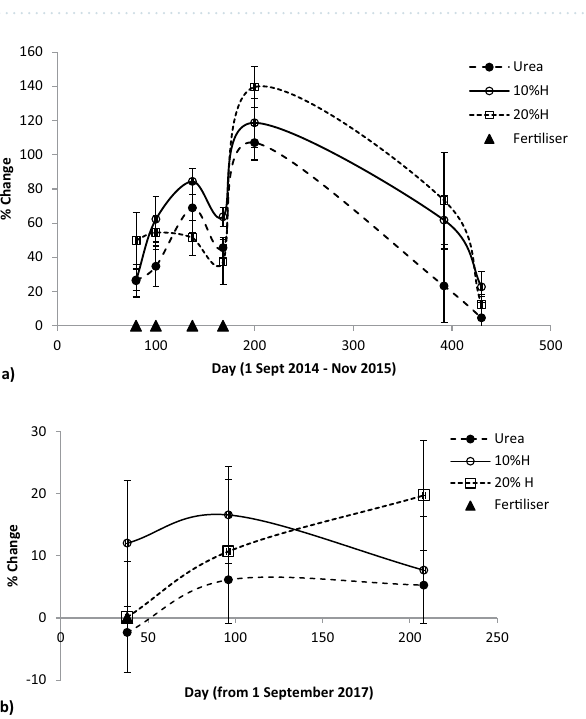
Figure 2. Effect of humate application rate on pasture production in March and September 2015 and 2014–2018, mean ± standard error. Longevity of urea and humate (H) effect on pasture production relative to unfertilised pasture ( a ) after summer application of the 2014–15 season to the start of the 2015–16 growing seasons and ( b ) after spring application in the 2017–18 season, mean ± standard